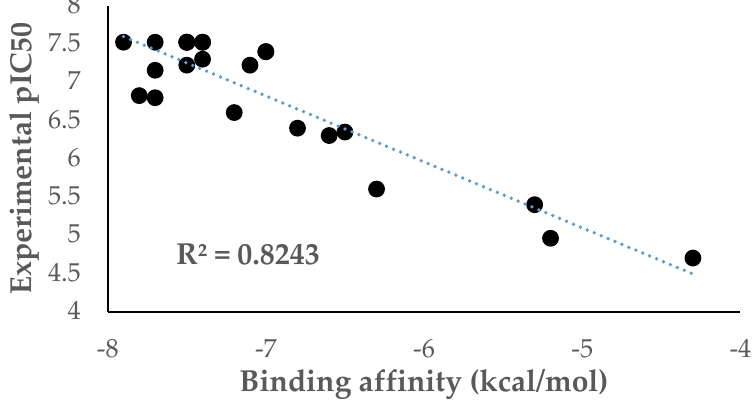
Figure 5. Plot for the binding affinity versus pIC 50.